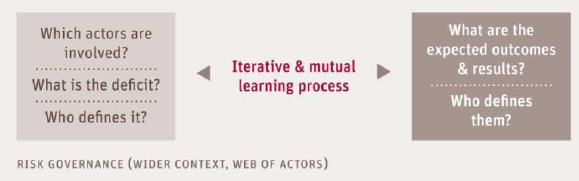
Figure 1. Questions to be answered in the process of social capacity building. Source: